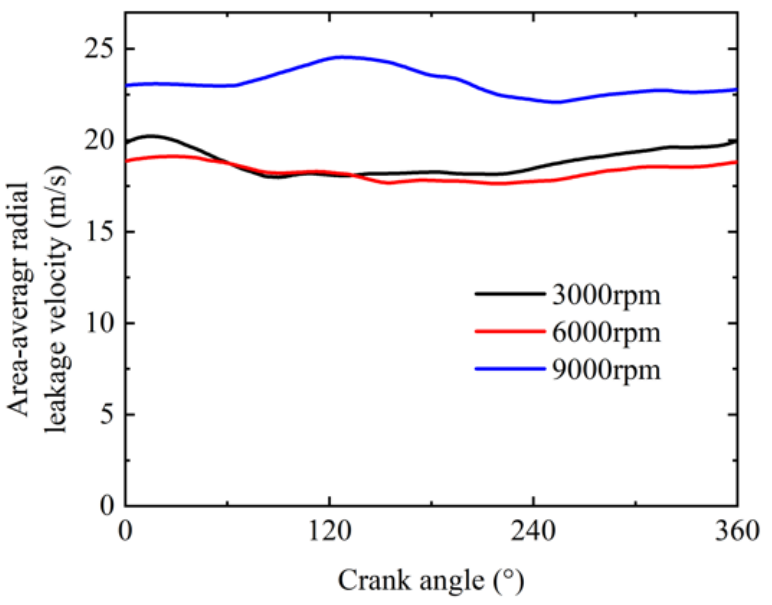
Figure 17. Area-average radial leakage velocity on the fl ank of the bo tt om axial clearance domain.